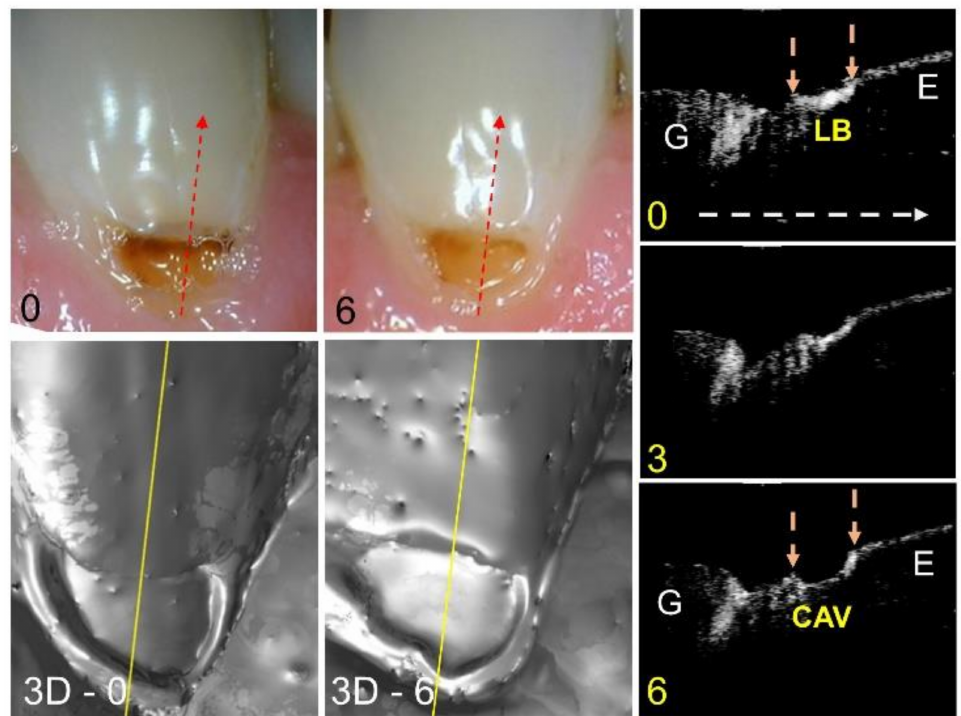
Figure 3. Color pictures at baseline and 6 months are shown for an active lesion with advancing cavitation. The dashed red lines show the likely position of the three CP-OCT b-scans shown at baseline, 3 months, and 6 months. The white dashed arrow in the OCT b-scan is directed from the root to the crown. Surface renderings (3D) of the entire CP-OCT scans taken at baseline and 6 months are also shown, with the yellow lines showing the position of the extracted b-scans. The position of the gingiva (G) and enamel (E) along with the lesion body (LB) are indicated. After 6 months, the demineralized area encompassing the lesion body between the two arrows has eroded, leaving a cavitated region